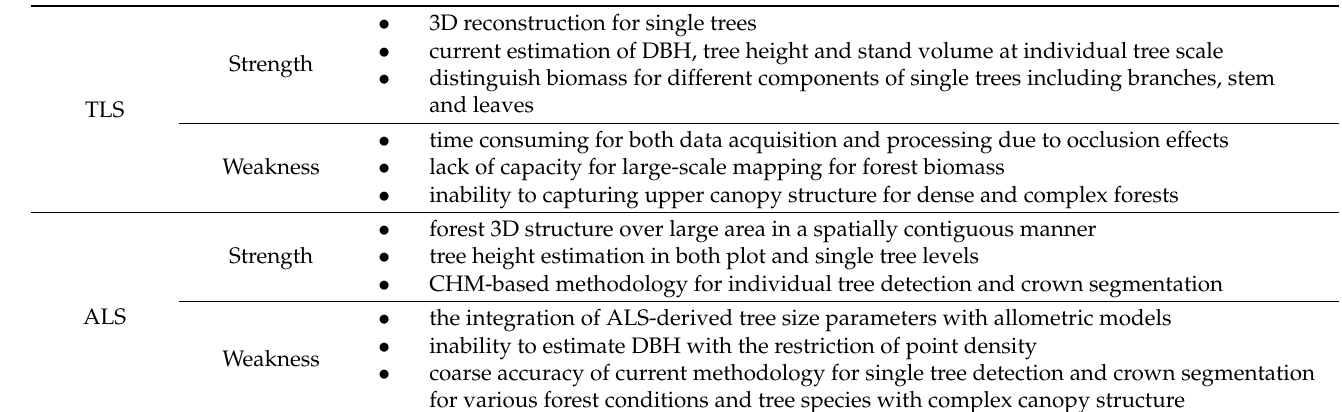
Table 1. Advantages and disadvantages of TLS, ALS, UAV-LS and BLS for AGB estimation for individual trees.